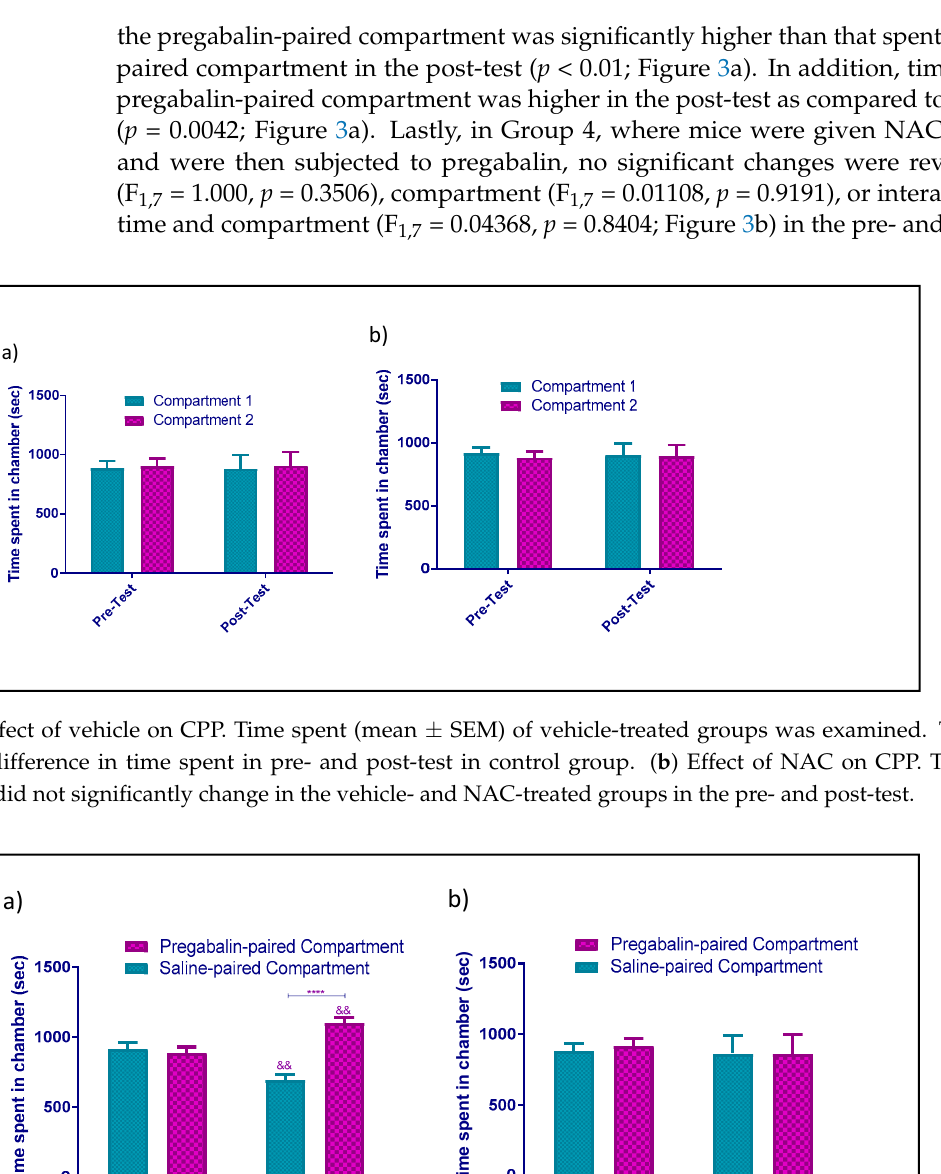
600 mg/day [57], and patients who experience euphoria and withdrawal symptoms